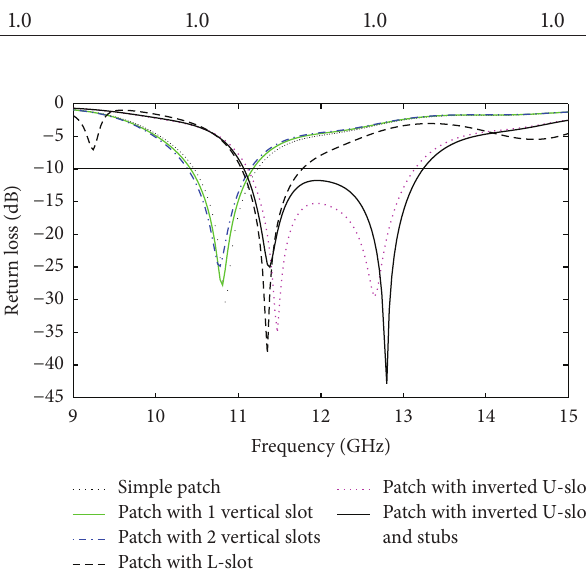
Figure 2: Dimensions of the aperture slot and feedline. Figure 3: Return loss plot of all the designs in which solid black line plot represents the return loss of proposed